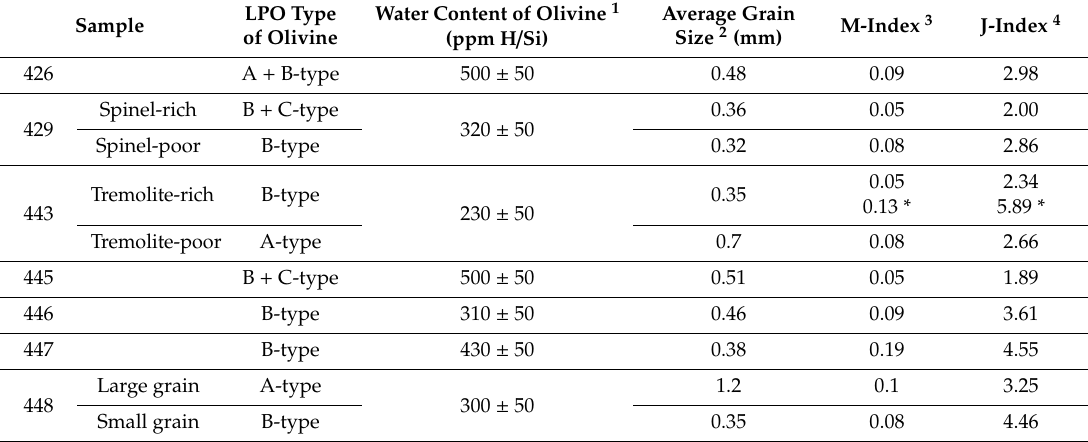
Table 1. The lattice-preferred orientations (LPO), water content, and fabric strength of